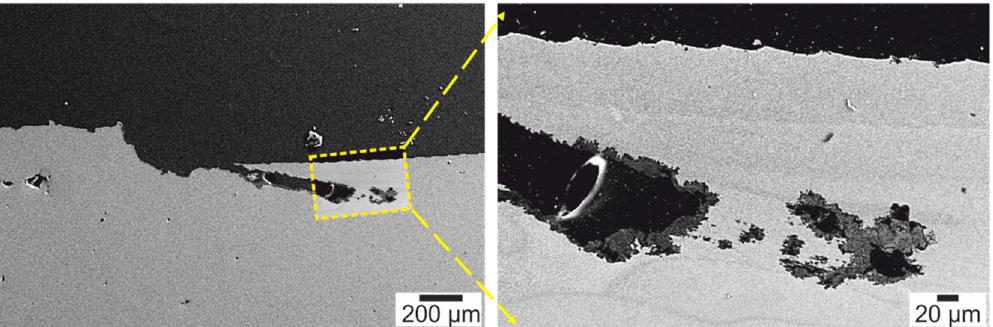
Figure 9. SEM-image of the transition area between the FSP zone and as-built SLM microstructure of the AC-FSP sample: the high-resolution micrograph (right hand side) is taken from the area marked by the yellow square.